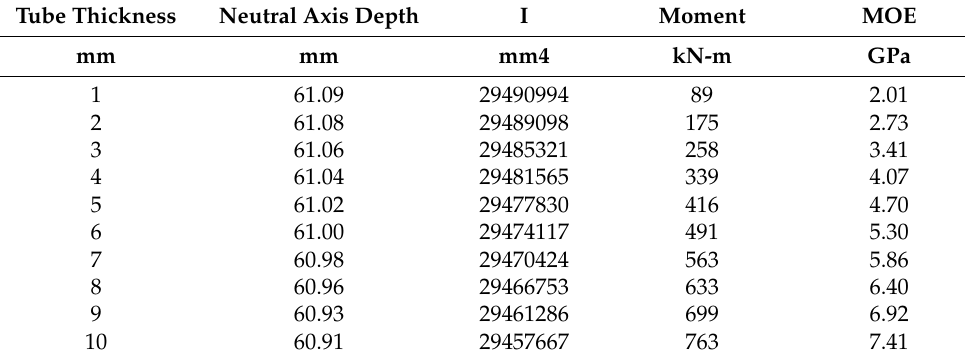
Table 3. Increase of Sleeper Capacity with Tube Thickness.